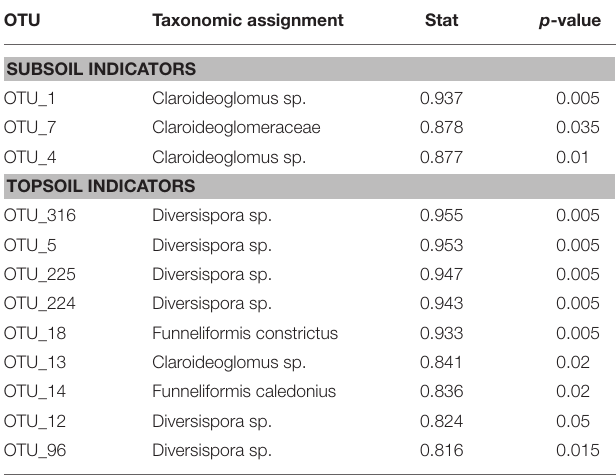
TABLE 1 | Identified sub- and top-soil